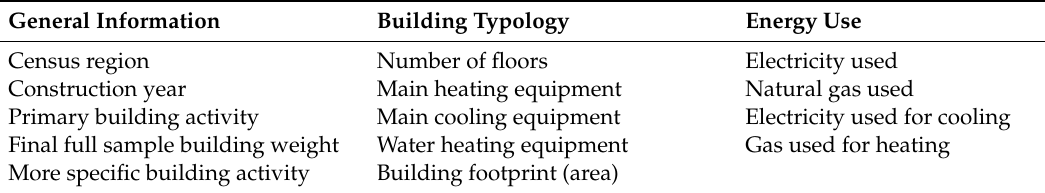
Table 4. Building and energy-use information included in RECS and